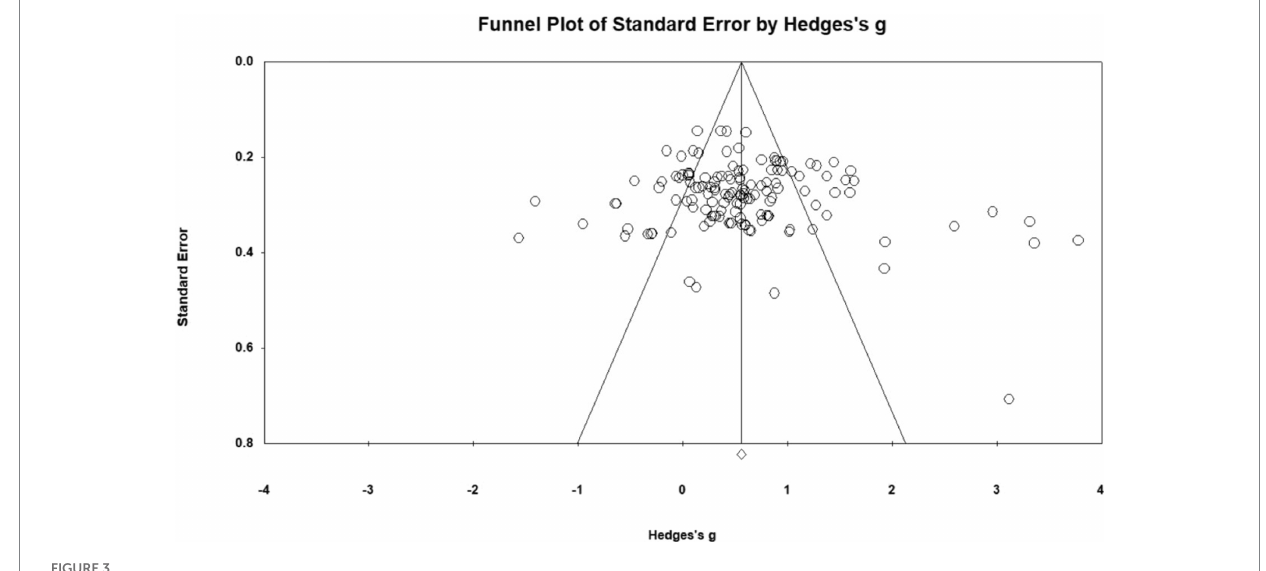
FIGURE 3 Funnel plot of standard errors by Hedges’ g effect sizes.